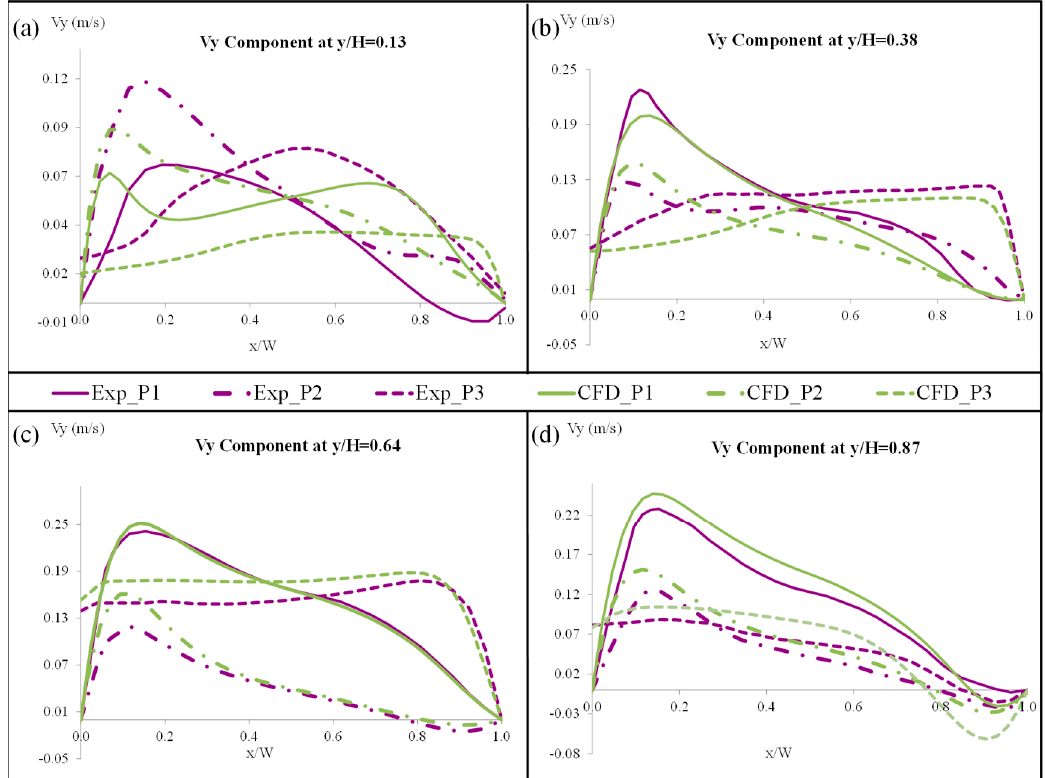
Figure 10. Temperature distribution inside the air cavity at three different planes.